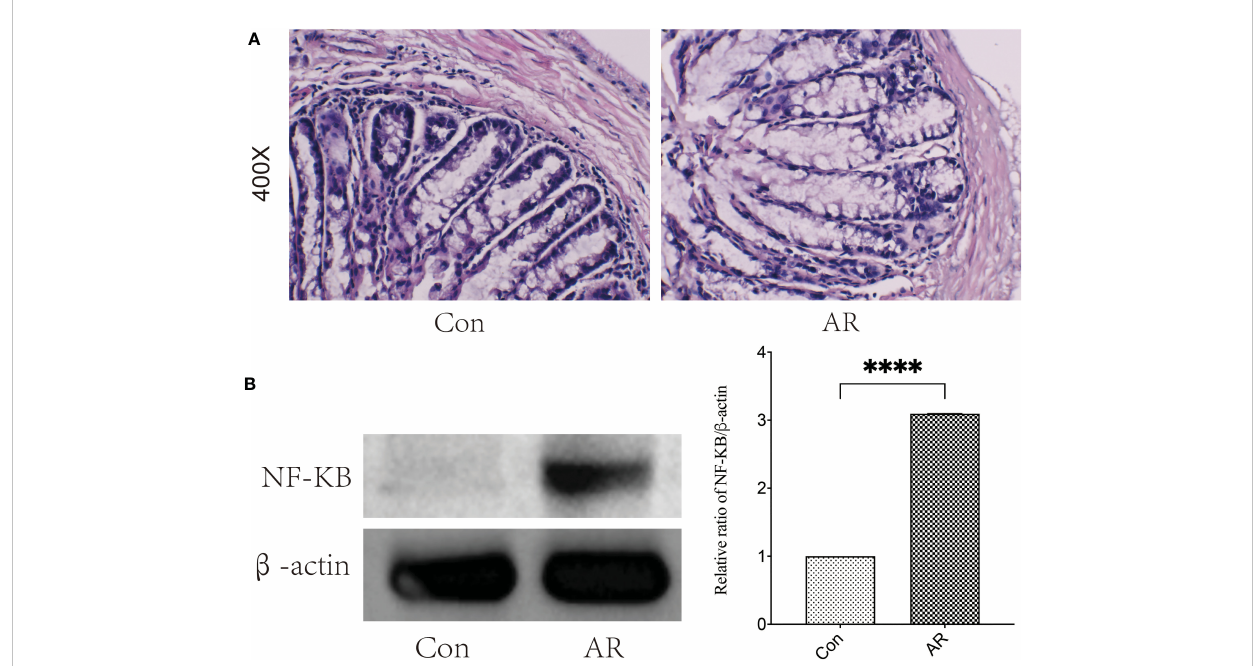
FIGURE 9 The severity of injury and in fl ammation in colon tissue increased in AR mice. (A) H&E staining of colonic mucosa (400×) (B) The protein expression of NF- k B was detected by western blotting. ****P <